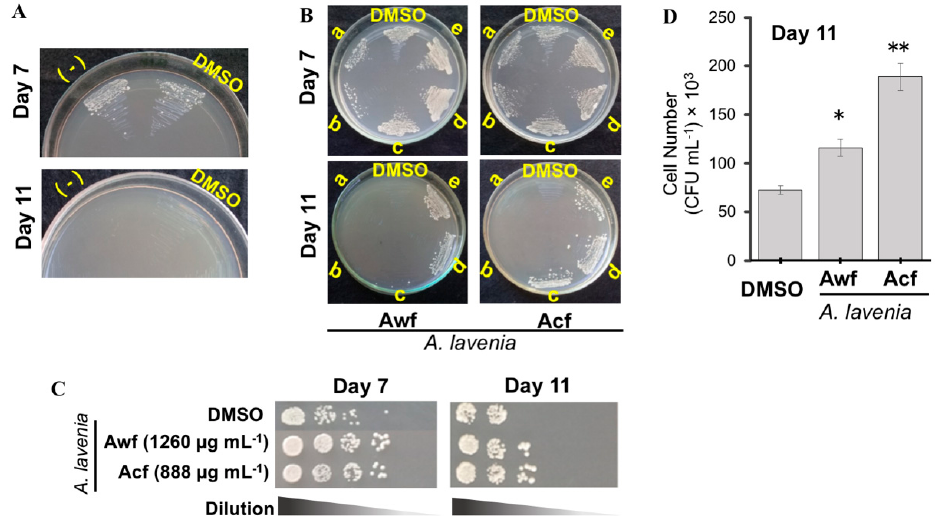
Figure 2. Antioxidative activity of A. lavenia extracts. ( A ) S. pombe was preincubated in the YES liquid medium with or without ( − ) DMSO for seven or 11 days and then streaked on agar plates containing 5 mM H 2 O 2 . ( B ) The effects of A. lavenia fractions on the oxidative stress resistance in the yeast cells were examined by the streaking method. A. lavenia Awf (a, 252; b, 504; c, 756; d, 1008; e, 1260 µg mL − 1 ) or Acf (a, 222; b, 444; c, 666; d, 888; e, 1110 µg mL − 1 ) were mixed in the YES liquid medium. At day 7 or 11, the yeast cells were streaked on plates supplemented with 5 mM H 2 O 2 . ( C ) The yeast cells that had been preincubated as in ( B ) were diluted and spotted on agar plates. ( D ) The number of CFU (colony-forming units) was obtained after 11 days of incubation of ( C ). Error bars represented S.D. from experiments performed in triplicate ( n = 5, * p < 0.05, ** p < 0.01).